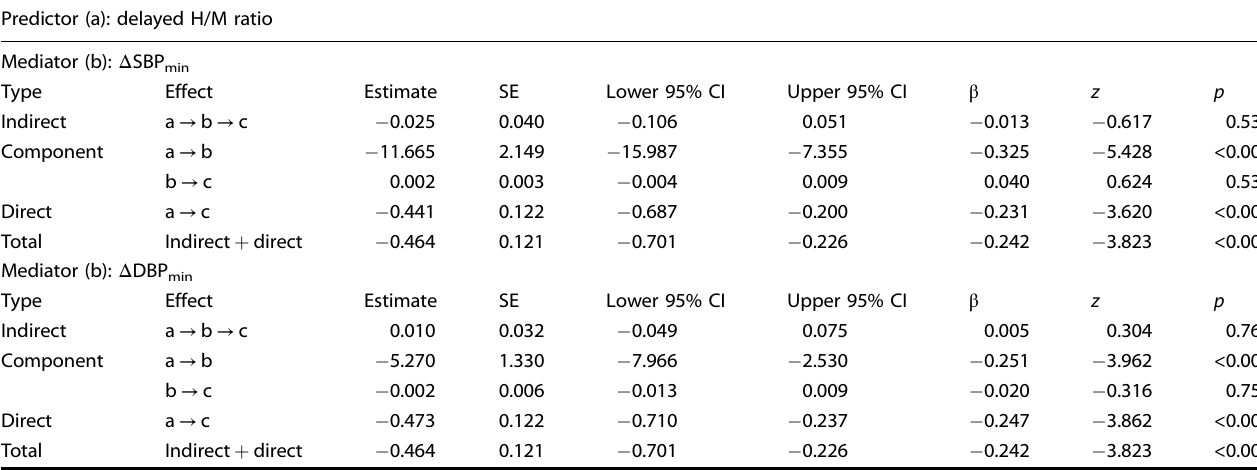
Table 2. The mediating effects of orthostatic blood pressure changes ( Δ SBP min , Δ DBP min ) on global composite score. Predictor (a): delayed H/M ratio Mediator (b): Δ SBP